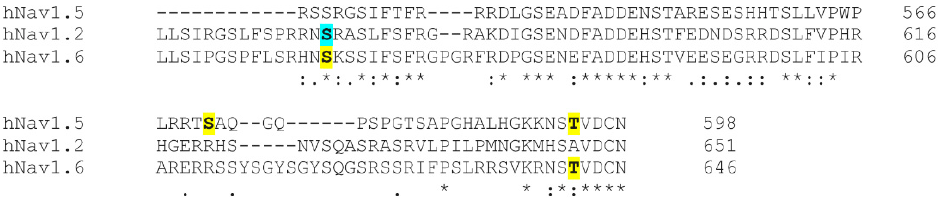
Figure 5. Sequence alignment spanning homologous phosphorylation sites in Na v 1.2, Na v 1.5, and Na v 1.6 in the L1 region between domains I and II. Blue represents PKA phosphorylation site. Yellow represents CaMKII phosphorylation site.